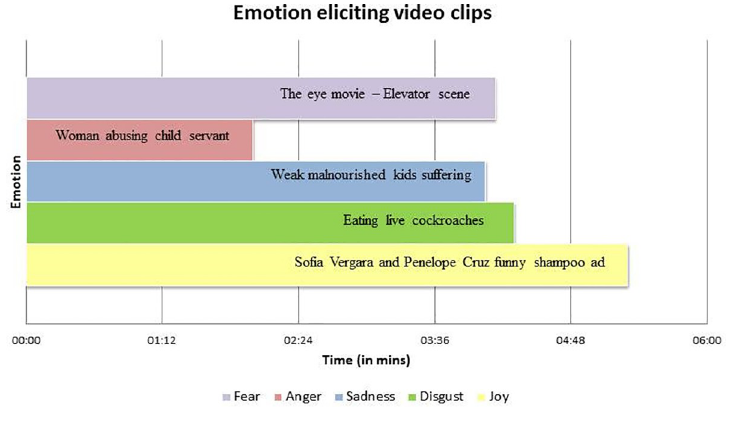
Fig 3. Emotion eliciting video